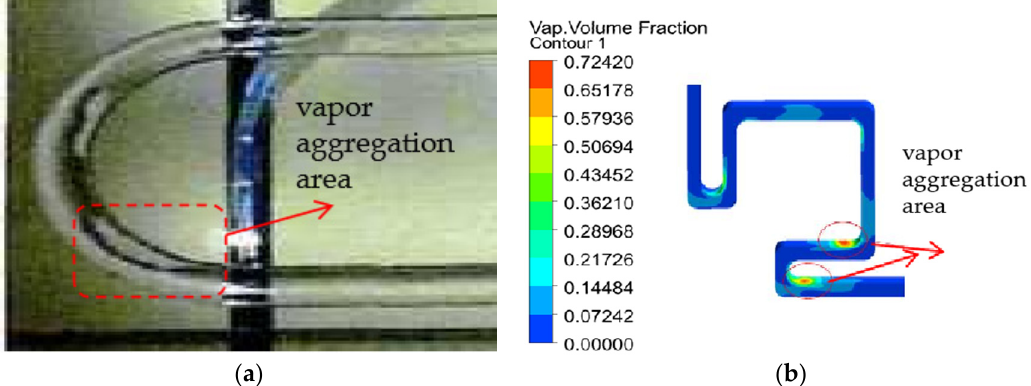
Figure 7. Vapor − liquid separation at the bend. ( a ) Nan’s experimental result [24]; ( b ) numerical re- sult.